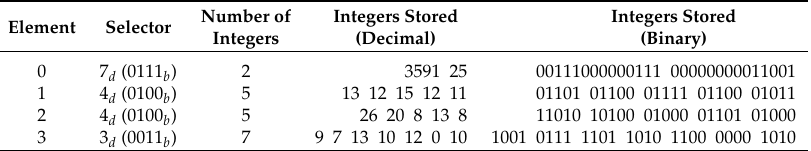
Table 5. Example to show how the integer sequence <3591 25 13 12 15 12 11 26 20 8 13 8 9 7 13 10 12 0 10> d is stored with